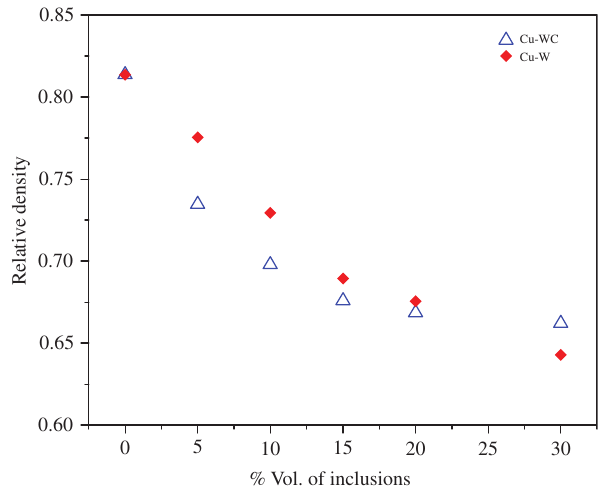
Figure 5: Evolution of the relative density as a function of the volume fraction of inclusions for the two kinds of inert inclusions used in this experiment.